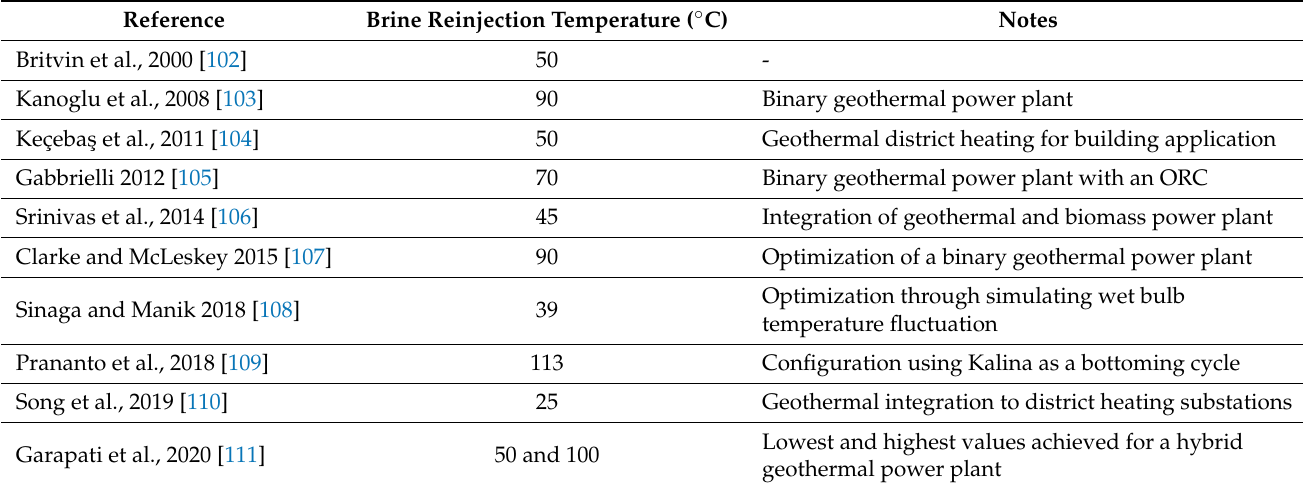
Table 9. Literature review of the values for geothermal selected